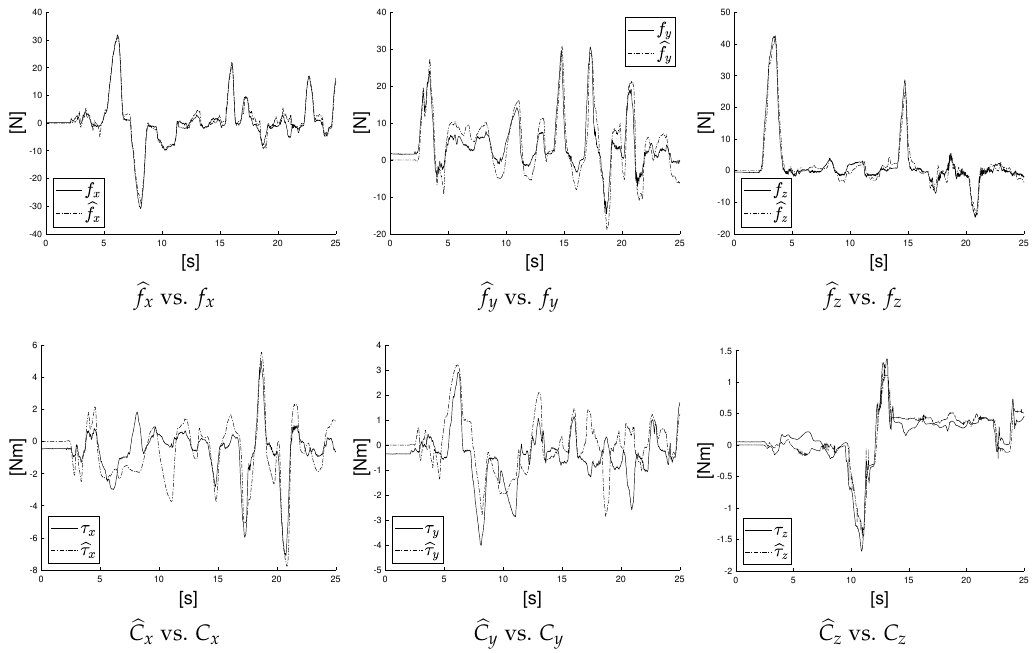
Figure 9. Estimated interaction forces (cid:98) f and torques (cid:98) C (continuous line) vs. measured interaction forces f and torques C (dashed line) for the #1 experimental